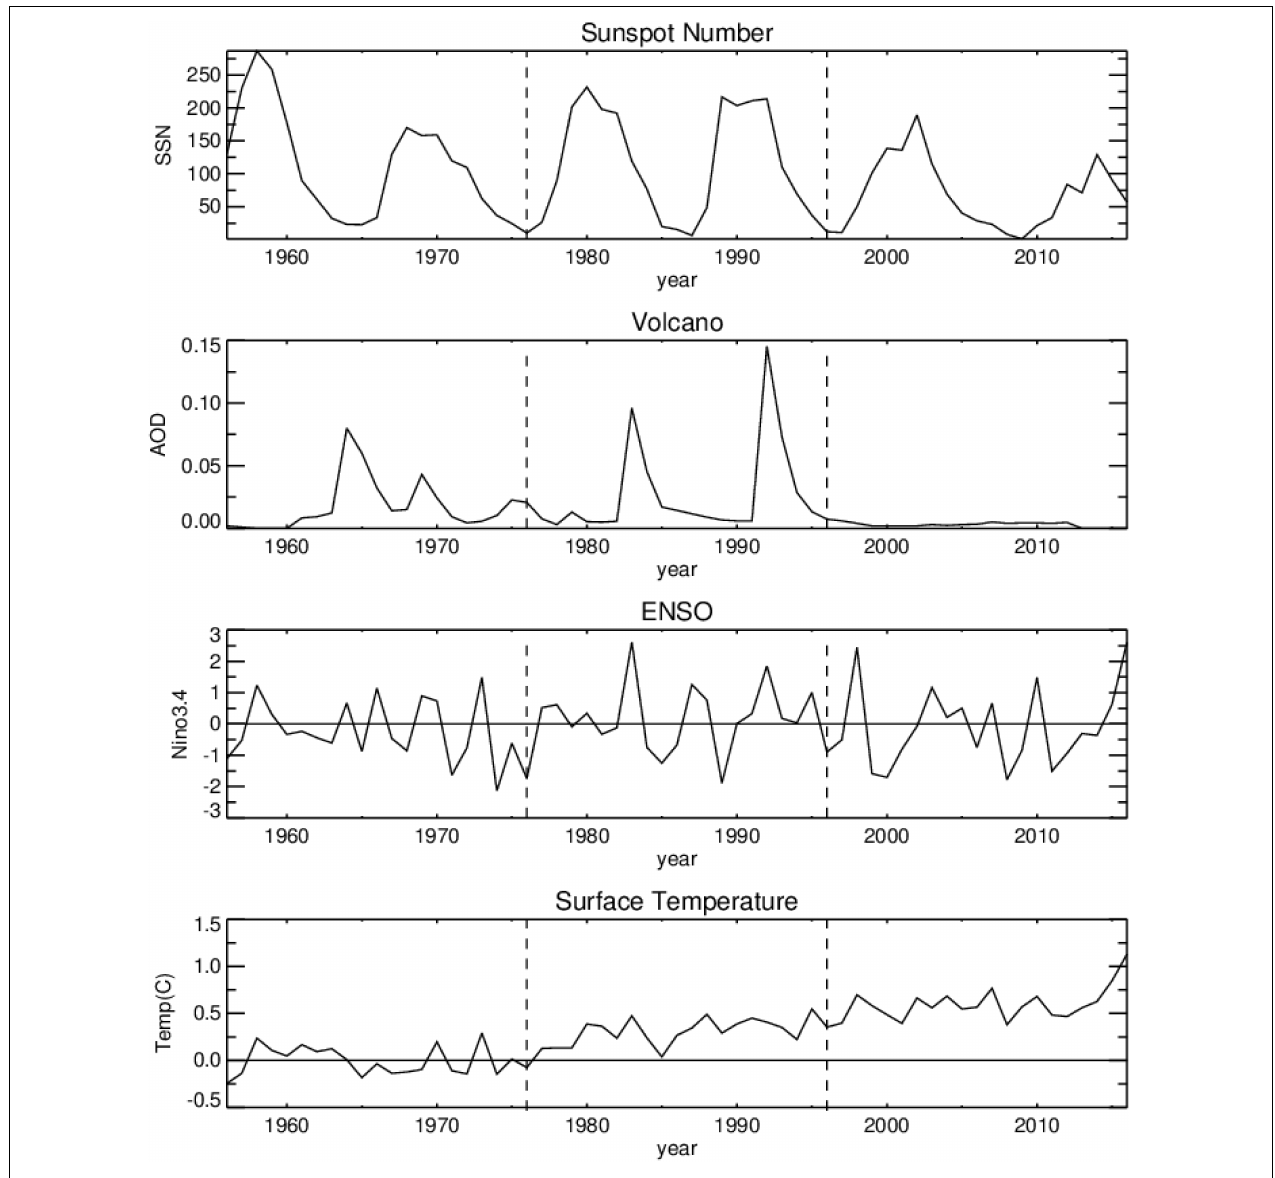
FIGURE 7 | Observed time series of various natural factors (solar cycle variability, volcano and ENSO) and global surface temperature. Solar cycle variability is represented by SSN, volcano by AOD and ENSO by Niño3.4 indices. The period 1976–1996, the time of abrupt global warming is marked by dotted lines. The period exceeding the right dotted lines represent the warming slowdown period. The warming in 2016 is distinct and it is seen linked with the strong El Niño of